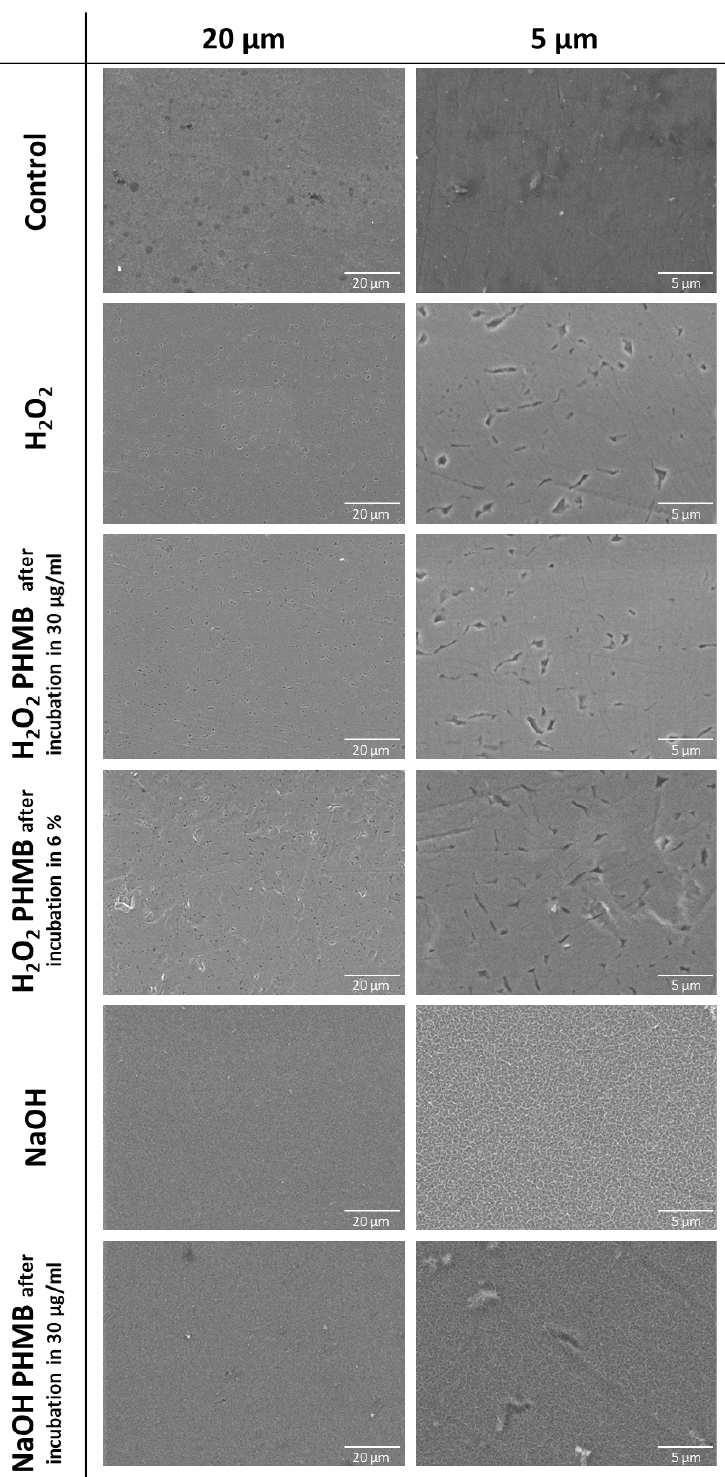
Figure 8. Surface characteristics of differently treated Ti6Al4V surfaces. Untreated Ti6Al4V specimens show an even surface. Treatment with H 2 O 2 led to the formation of an isle-like structure. The NaOH treatment resulted in a quite different pattern, that can be described as network-like. Adsorption of PHMB had no influence on surface structure visible with